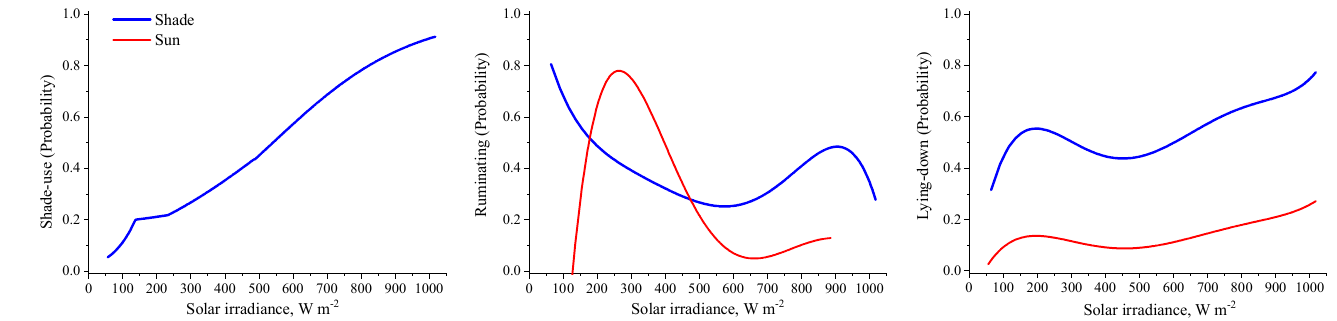
Figure 3. Probability of shade use of heifers as a function of solar irradiance. The positive outcome of shade-use behavior for animals is also the abatement of direct short-wave solar radiation. By seeking shade, the heifers were able to avoid short-wave solar load in the amount of 1000 W m −2 (Table 1). On a clear sky day, the direct solar component represents 80% of the total short-wave input [3]. The shade also serves as a heat sink for animals, especially when it is not projected below the roof structure. The efficiency of the energy conversion of photovoltaic cells ranges between 15 and 25%. Part of the solar beam that is intercepted by the solar panels is absorbed as heat, thus increasing the temperature of the external and inner surfaces of the solar modules. Between 10:00 and 14:00 h, the temperature of the inner surface of the solar panels was between 35 and 38 °C. During this time interval, the solar elevation angle is near the zenith, and the shade is projected below the solar panels. Under such circumstances, if the body surface temperature of the heifers is below 35 °C, then the balance of the thermal radiation